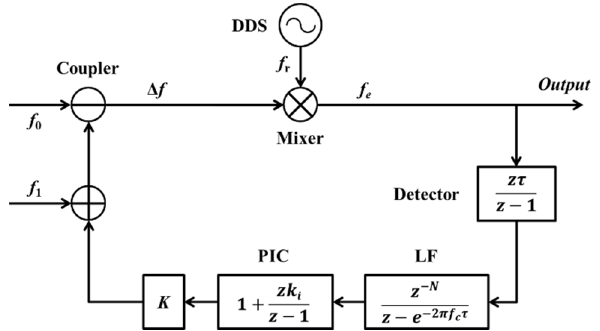
Figure 4. Small-signal model of the HHD-OPLL.